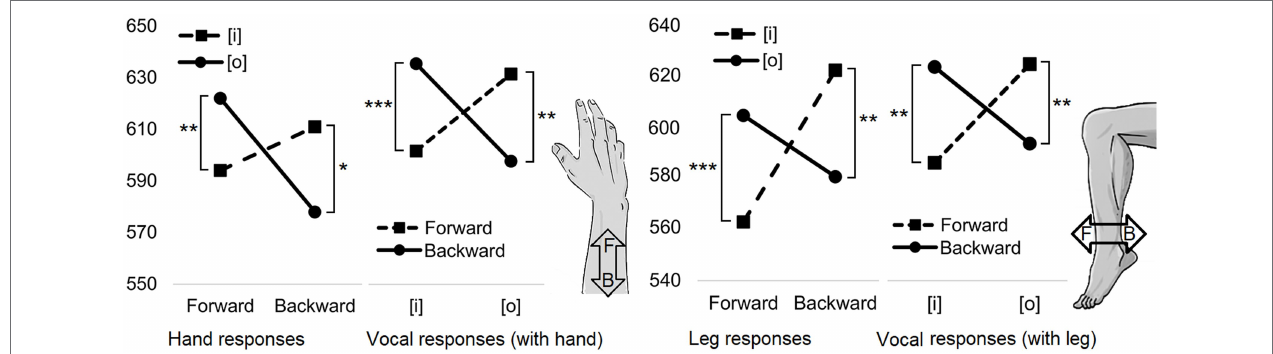
FIGURE 3 | The RT effect for the study published by Vainio et al. (2019b). In the experimental task, the participants were visually presented with the vowel [i] or [o]. The participants had to respond by moving their right hand (the left line graphs) or right leg (the right line graphs) either forward or backward according to the color (green/ blue) of the letter while simultaneously pronouncing the vowel. Limb movements and vocalizations were produced particularly rapidly when the limb was moved forward and the vowel was [i], and when the limb was moved backward and the vowel was [o]. In the images of hand and leg, the letter F (inside the arrow) refers to the word “forward” and the letter B refers to the word “backward.” Asterisks indicate statistically significant differences (*** p < 0.001; ** p < 0.01; and * p <